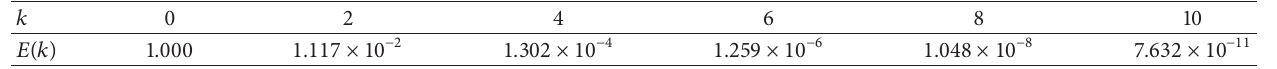
Table 1: 𝐸(𝑘) : 𝑘 = 2𝑖,𝑖 = 0,1,2,3,4,5